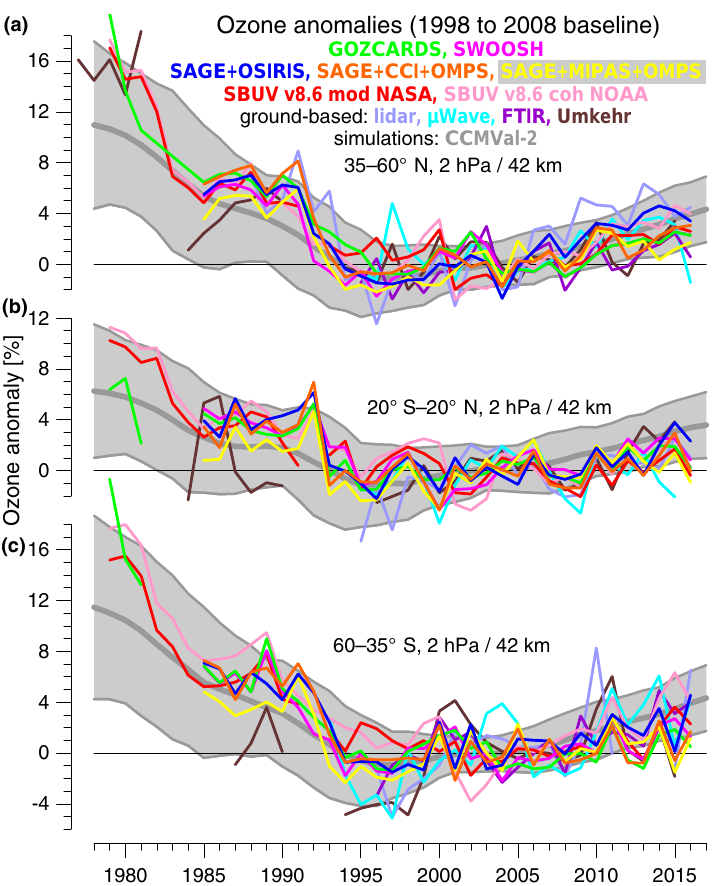
Figure 1. Annual mean ozone anomalies near 2hPa or 42km, as recorded by merged satellite data sets and ground-based stations. Anomalies are referenced to the 1998 to 2008 climatological annual cycle of each individual data set, and are averaged over the indicated zonal bands. Stations close to a zonal band are also included, i.e., NDACC lidar data from Table Mountain at 34 . 4 ◦ N, NDACC FTIR data from Izaña at 28 . 3 ◦ N and Wollongong at 34 . 4 ◦ S, and Umkehr data from Perth at 34.7 ◦ S are included in the respective midlatitude bands. Due to con- tamination by volcanic aerosol after the eruptions of El Chichon and Mt. Pinatubo, Umkehr data are not used for the years 1982, 1983, and 1991 to 1993, and SBUV-NASA data are not available for 1992. Grey lines show the multimodel mean ozone anomalies from CCMVal-2 simulations (Eyring et al., 2010), with the grey shading giving the ± 2SD envelope. Mean and SD are taken over all models (except outliers) and within a 25-month sliding